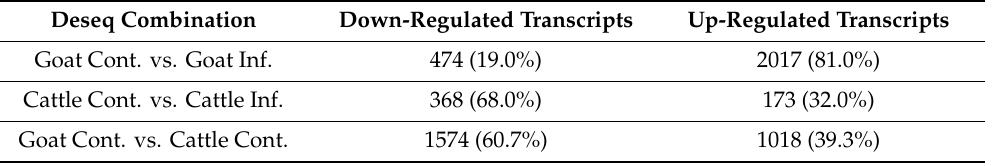
Table 4. Di ff erentially expressed transcripts identified from the RNAseq generated across the Control and PPRV-infected Goat and Cattle PBMC using the Cu ff di ff program of the Cu ffl inks package ( p -value < 0.05). Deseq Combination Down-Regulated Transcripts Goat Cont. vs. Goat Inf. Cattle Cont. vs. Cattle Inf. 173 (32.0%) Goat Cont. vs. Cattle Cont. 1574 (60.7%) (Data represented from the bioinformatic analysis under project p4365).